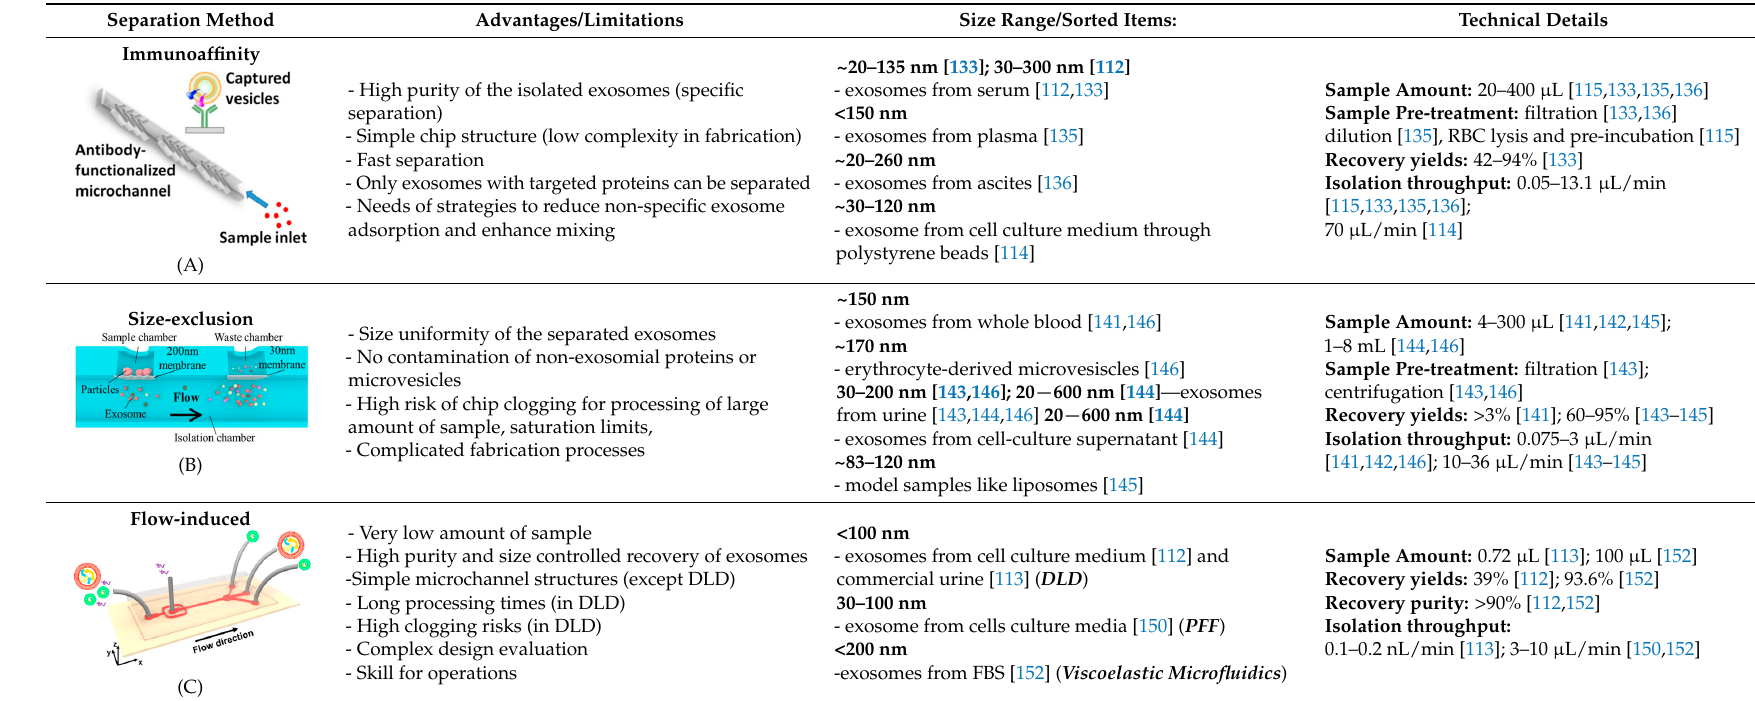
Table 3. Summary of passive methods to isolate EVs, with schemes of working of the main techniques. (A) immunoaffinity methods include the functionalization of the channel with antibodies able to hold the desired microvesicles (MVs), (B) size-exclusion scheme for the entrapment of exosomes (reprinted with permission of [143]), (C) working principle of flow-induced method (reprinted with permission from reference [152], Copyright 2017 American Chemical Society).